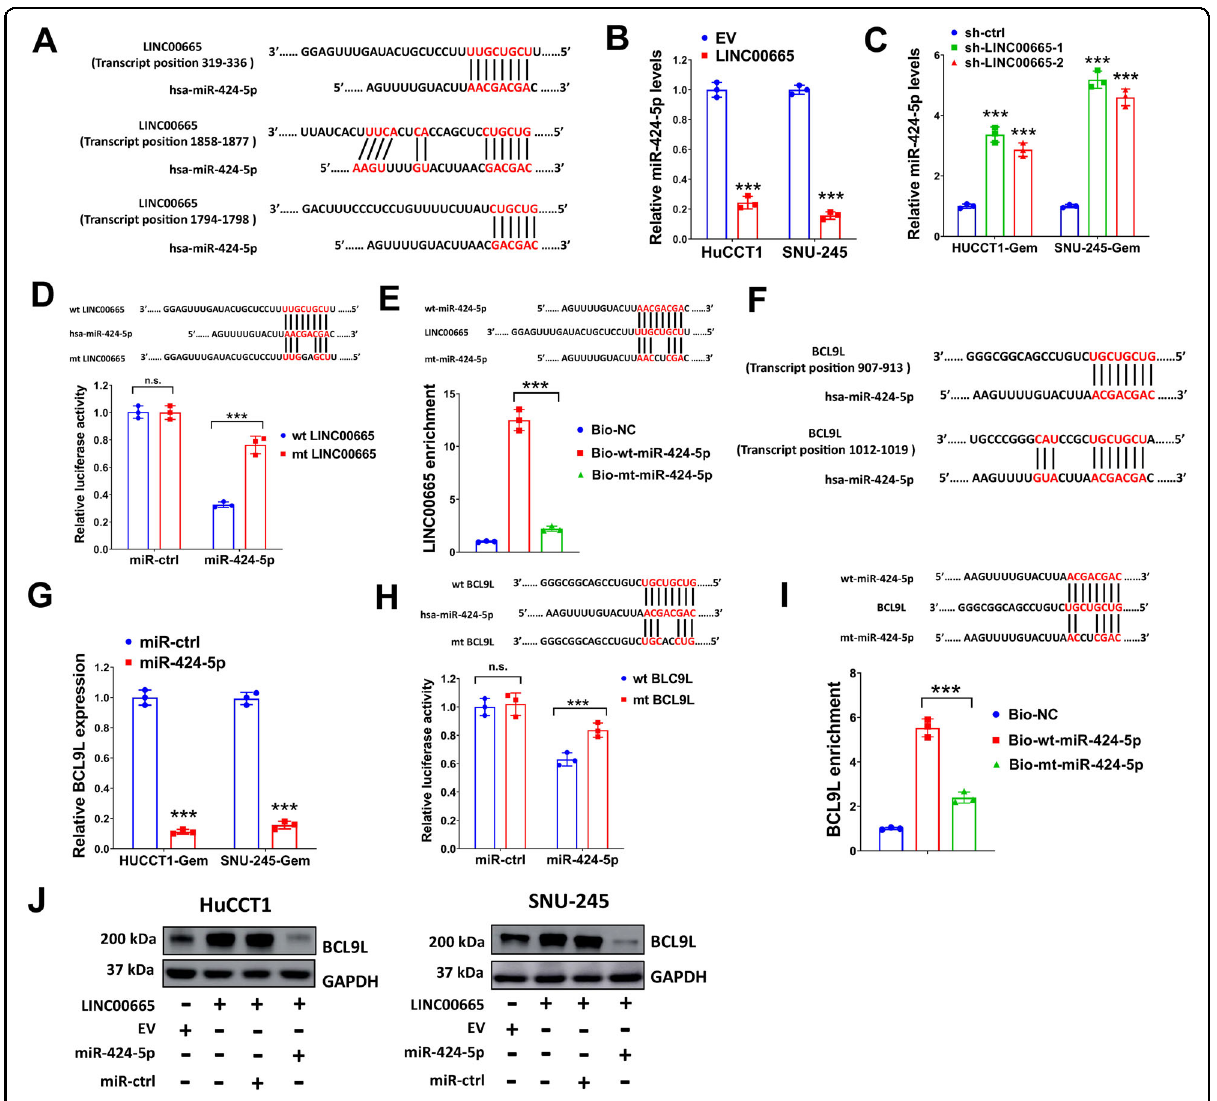
Fig. 6 LINC00665 regulates BCL9L expression by acting as a molecular sponge for miR-424-5p. A the putative binding sites for LINC00665 and miR-424-5p were shown. B HuCCT1 and SNU-245 cells transduced with LINC00665 expression lentivirus or EV, then relative miR-424-5p expression was evaluated by qRT-PCR. C HuCCT1-Gem and SNU-245-Gem cells were transduced with sh-LINC00665-1, sh-LINC00665-2, or sh-ctrl, then relative miR-424-5p expression was evaluated by qRT-PCR. D HEK293T cells transduced with wt LINC00665 or mt LINC00665 expression pMIR-REPORT vector were used for luciferase reporter assay. Cells were co-transfected with miR-424-5p or miR-ctrl expression vector as indicated. E Relative expression of LINC00665 in the bound RNAs pulled down by biotinylated wild-type (wt) miR-424-5p, mutant (mt) miR-424-5p, and non-targeting control (NC) were evaluated by qRT-PCR. F the putative binding sites for BCL9L and miR-424-5p were shown. G HuCCT1-Gem and SNU-245-Gem cells transduced with miR-424-5p expression lentivirus or miR-ctrl, then relative BCL9L expression was evaluated by qRT-PCR. H HEK293T cells transduced with wt BCL9L or mt BCL9L expression pMIR-REPORT vector were used for luciferase reporter assay. Cells were co-transfected with miR-424-5p or miR-ctrl expression vector as indicated. I Relative expression of BCL9L in the bound RNAs pulled down by biotinylated wild-type (wt) miR-424-5p, mutant (mt) miR-424- 5p, and non-targeting control (NC) were evaluated by qRT-PCR. J HuCCT1 and SNU-245 cells were transduced with LINC00665 expression lentivirus, EV, miR-424-5p, or miR-ctrl as indicated, then expression of BCL9L was evaluated by western blot. *** P ≤